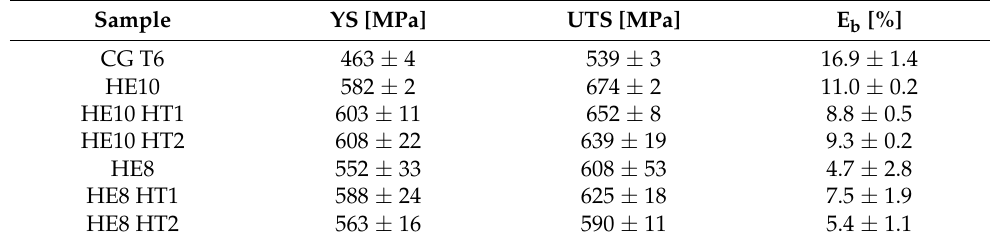
Table 3. Results obtained from the tensile tests.